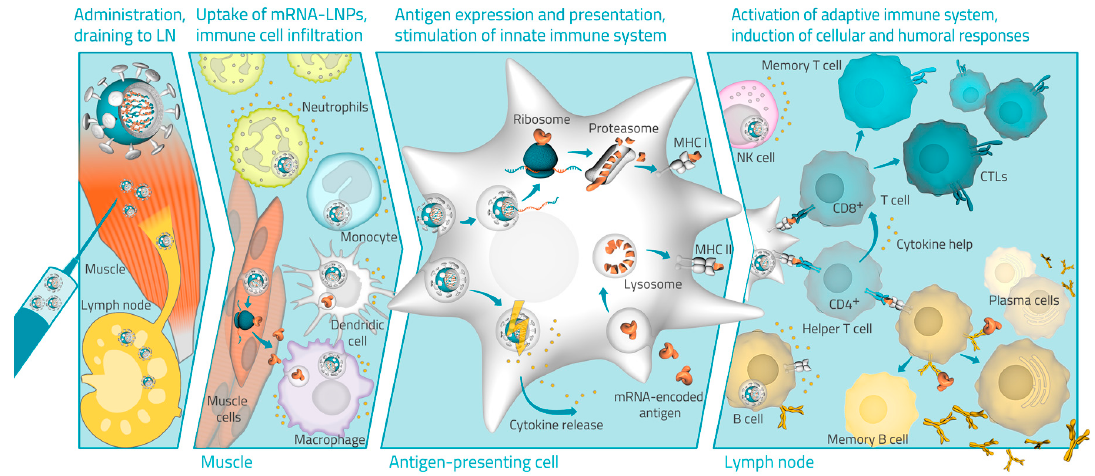
Figure 6. Schematic illustration of the mode of action of LNP mRNA formulations.